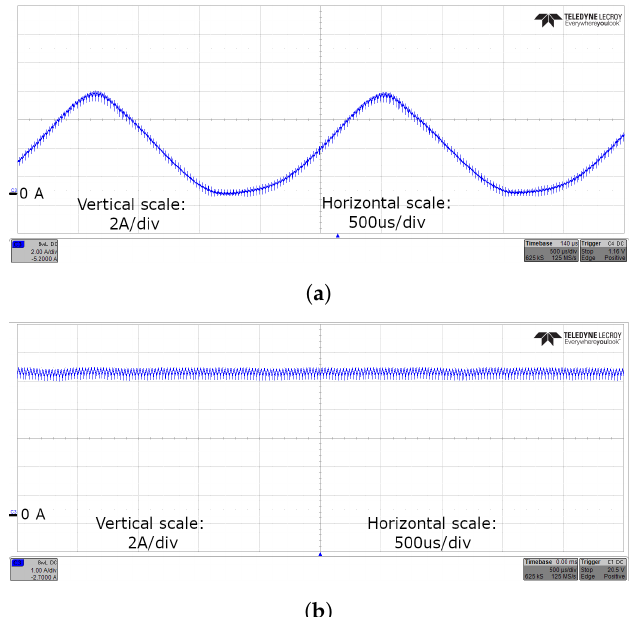
Figure 13. Output current waveforms, with ( a ) and without ( b ) network-induced jitter. The oscilloscope settings are as follows: 500µs horizontal scale, 2A/div, and